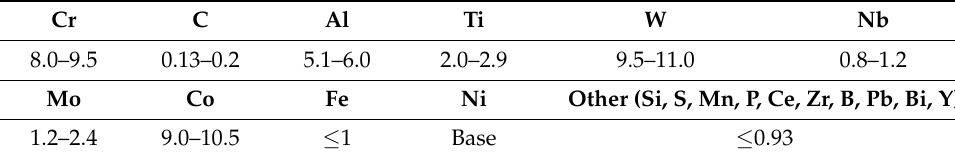
Table 1. Chemical composition of ZhS6U (K465) superalloy